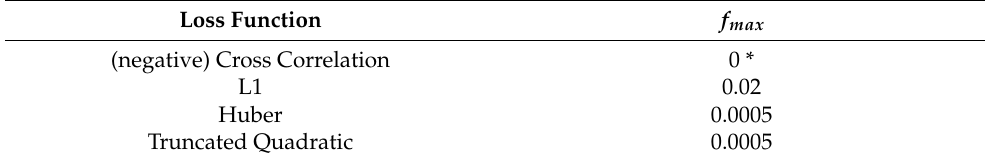
Table 3. Maximum objective function value f max for different loss functions. For none-normalized cross correlation (*), the objective function value is directly related to the depth of the soundings. It is therefore not feasible to select a meaningful value as a threshold and it is not considered for the quality of a match at